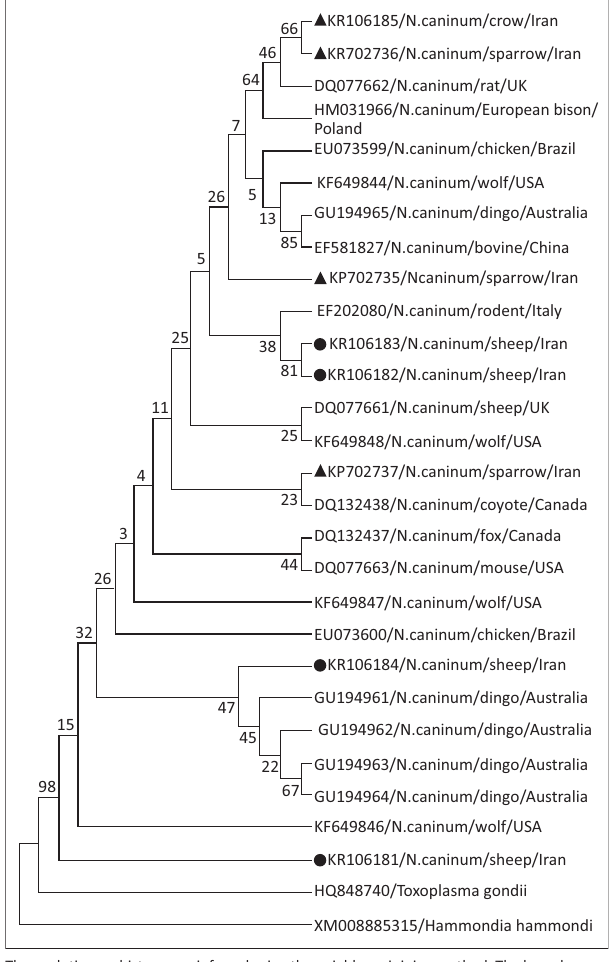
The evolutionary history was inferred using the neighbour-joining method. The branches are supported by 1000 bootstrap replicates. , Neospora caninum isolated in the present study; , denotes Neospora caninum isolates in Iran. FIGURE 2: Phylogenetic relationships among Neospora caninum specimens based on a fragment of the Nc-5